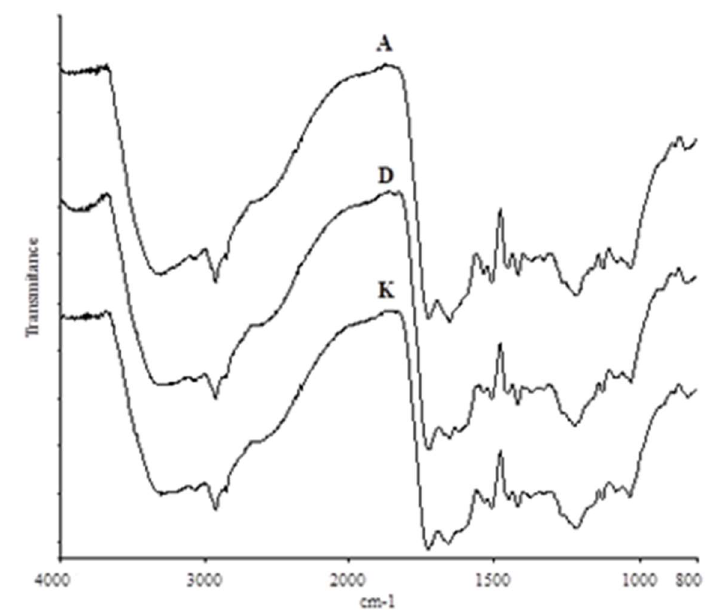
Figure 3. Selected FT-IR spectra of humic acids.